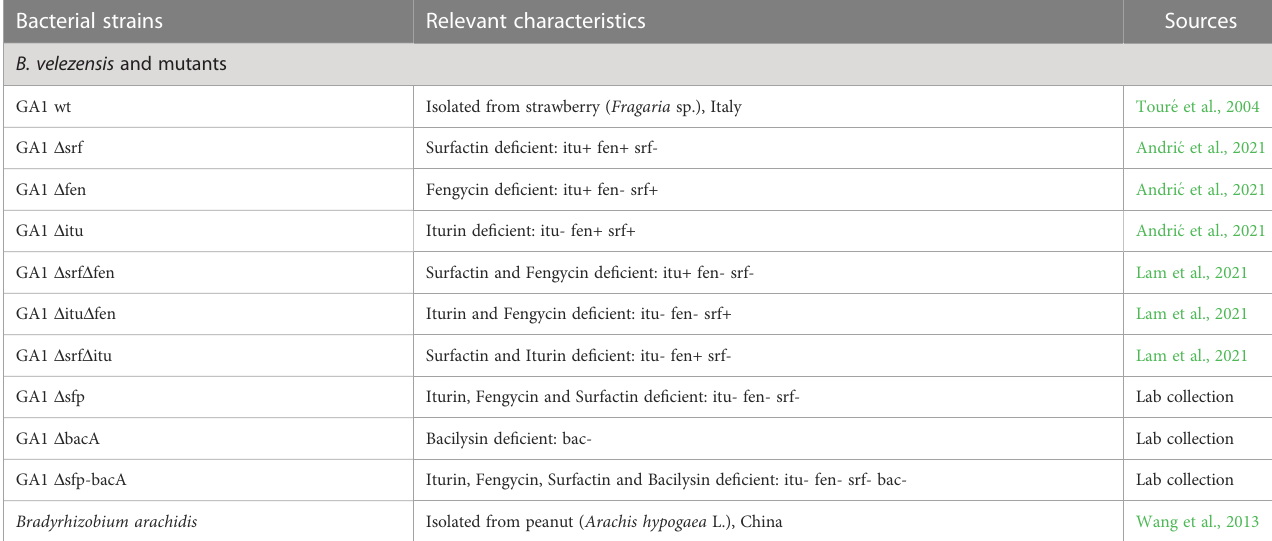
TABLE 1 Bacterial strains used in this